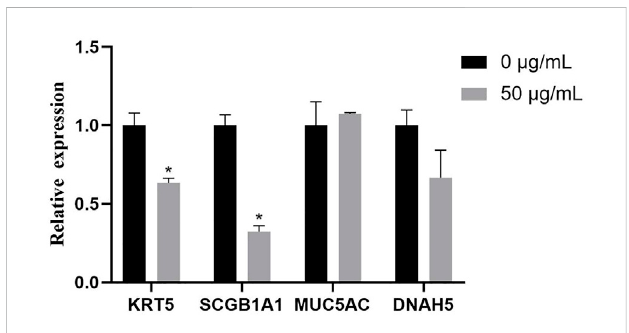
FIGURE 8 qPCR analysis for genes of hAO cell-speci fi c markers for basal cells ( KRT5 ), club cells ( SCGB1A1 ), goblet cells (MUC5AC), and ciliated cells